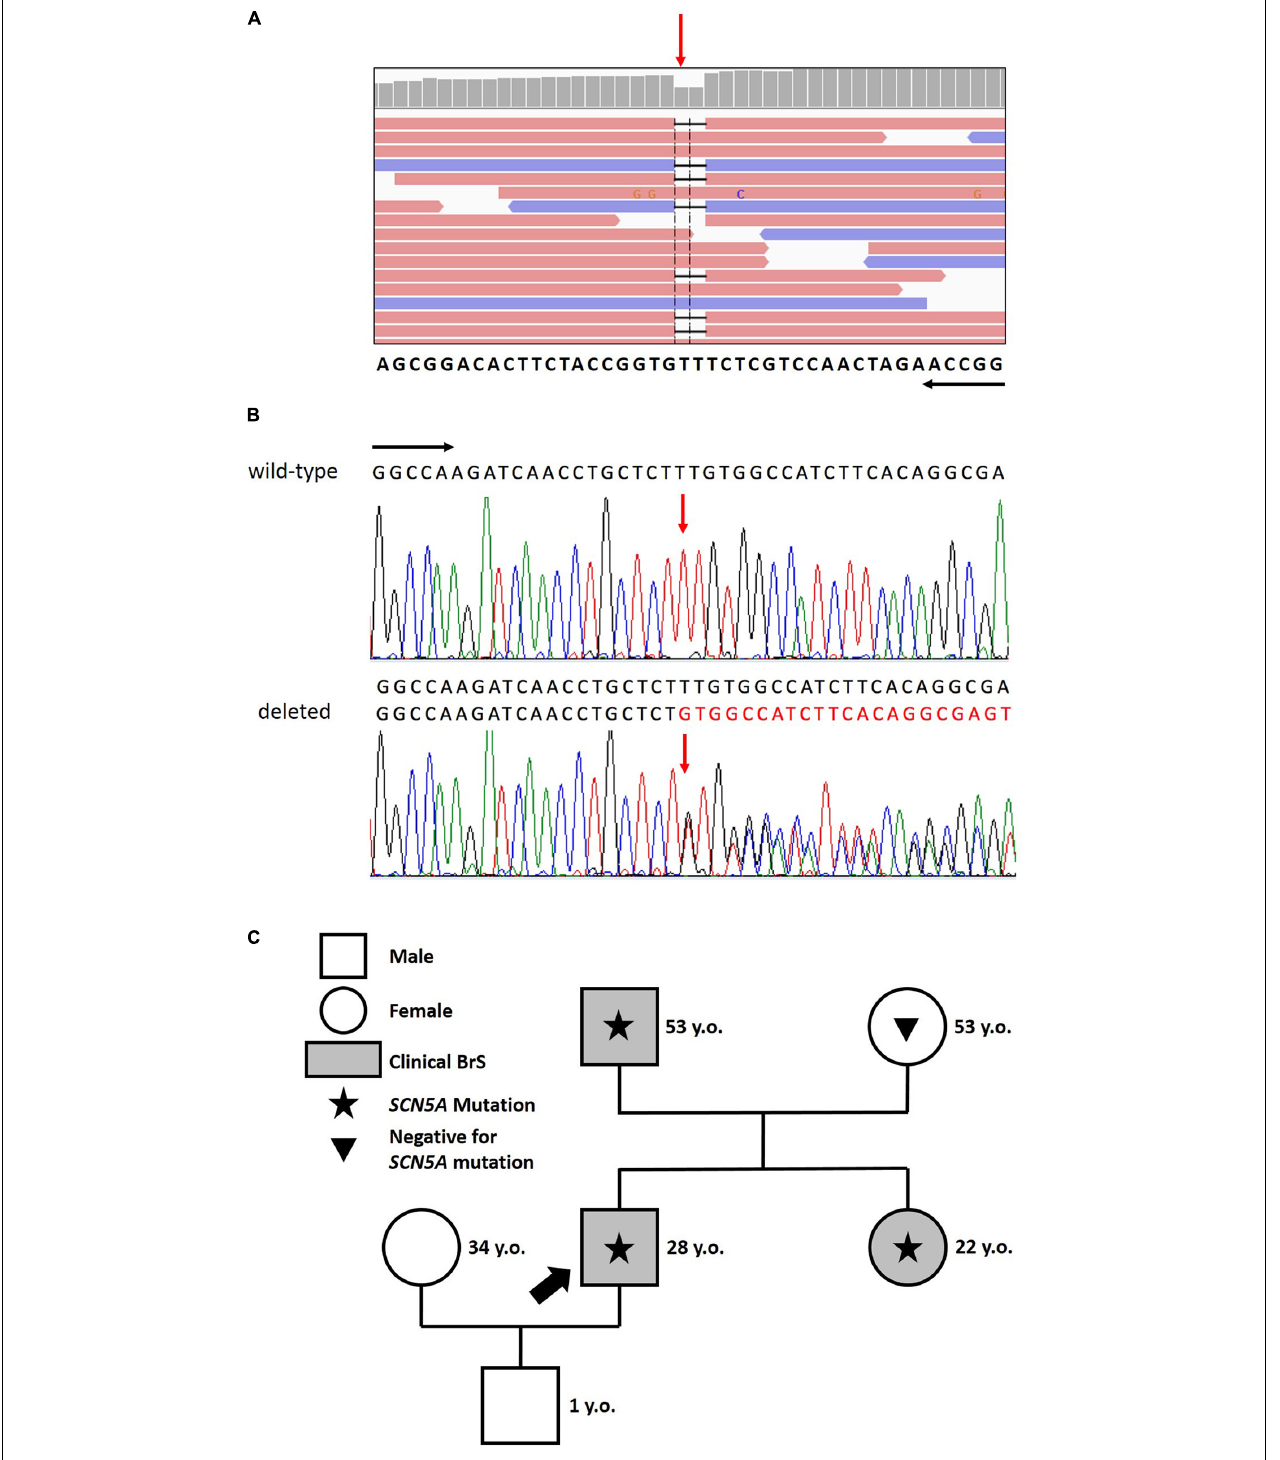
FIGURE 2 | (A) Identification of the heterozygous c.4700_4701del deletion by next generation sequencing. NGS paired-end reads loaded in the IGV genome browser. The gene sequence is in the reverse orientation on the chromosome. (B) Identification of the heterozygous c.4700_4701del deletion by sanger sequencing. Sanger sequencing confirmation of the deletion compared with the wild-type sequence. The wt (black) and mutated (red) sequences are reported. The position of the two bases deleted is indicated by the red arrow. Black arrows indicate the direction of the gene. (C) Family pedigree. Proband identified with an arrow. Square: male; Circle: female; Shaded: clinically affected by Brugada syndrome; Star: molecularly confirmed SCN5A mutation: Triangle: genetically tested and negative for SCN5A mutation.